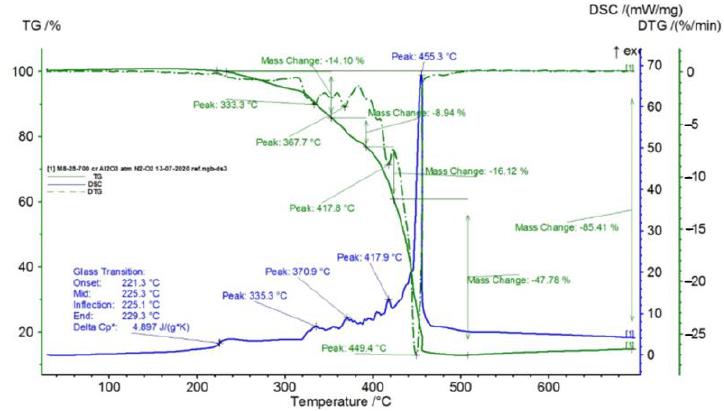
Figure 3. TG/DSC curves registered for TPU.